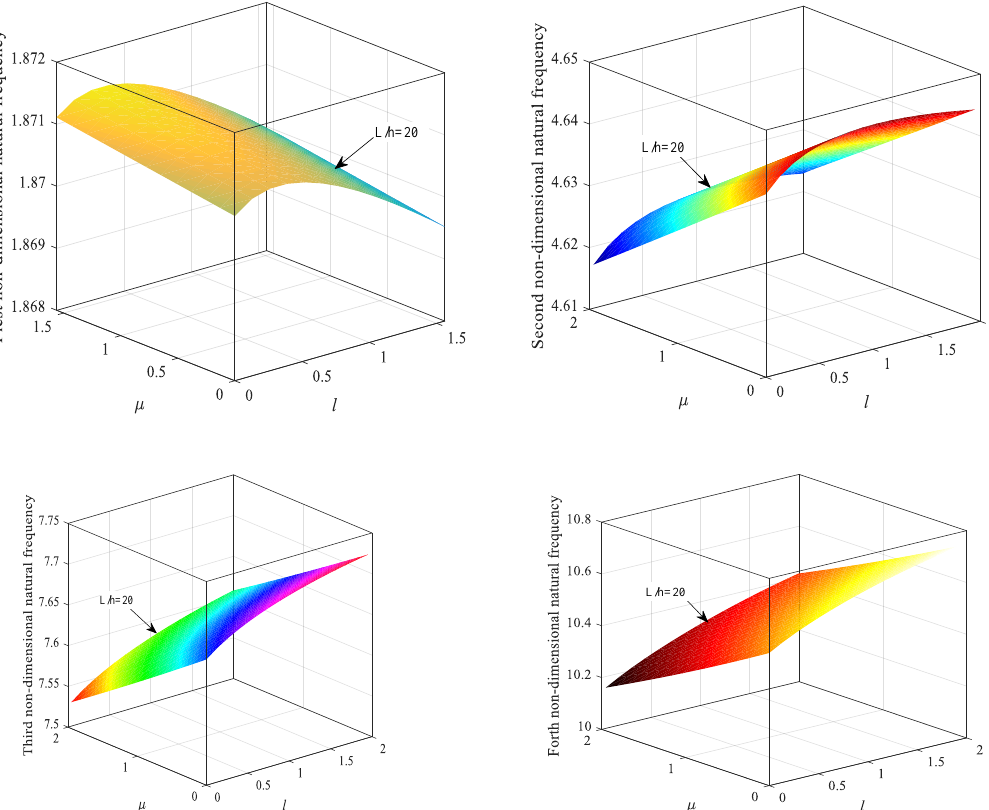
Figure 5. Variation of the first four natural frequencies for different L/h and small-scale parameters (clamped-free cantilever nanobeam).